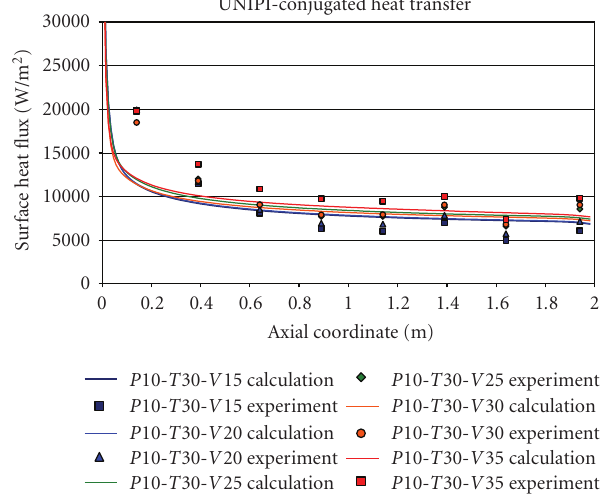
Figure 15: Results for the local heat flux obtained by the University of Pisa in the Condensation Benchmark